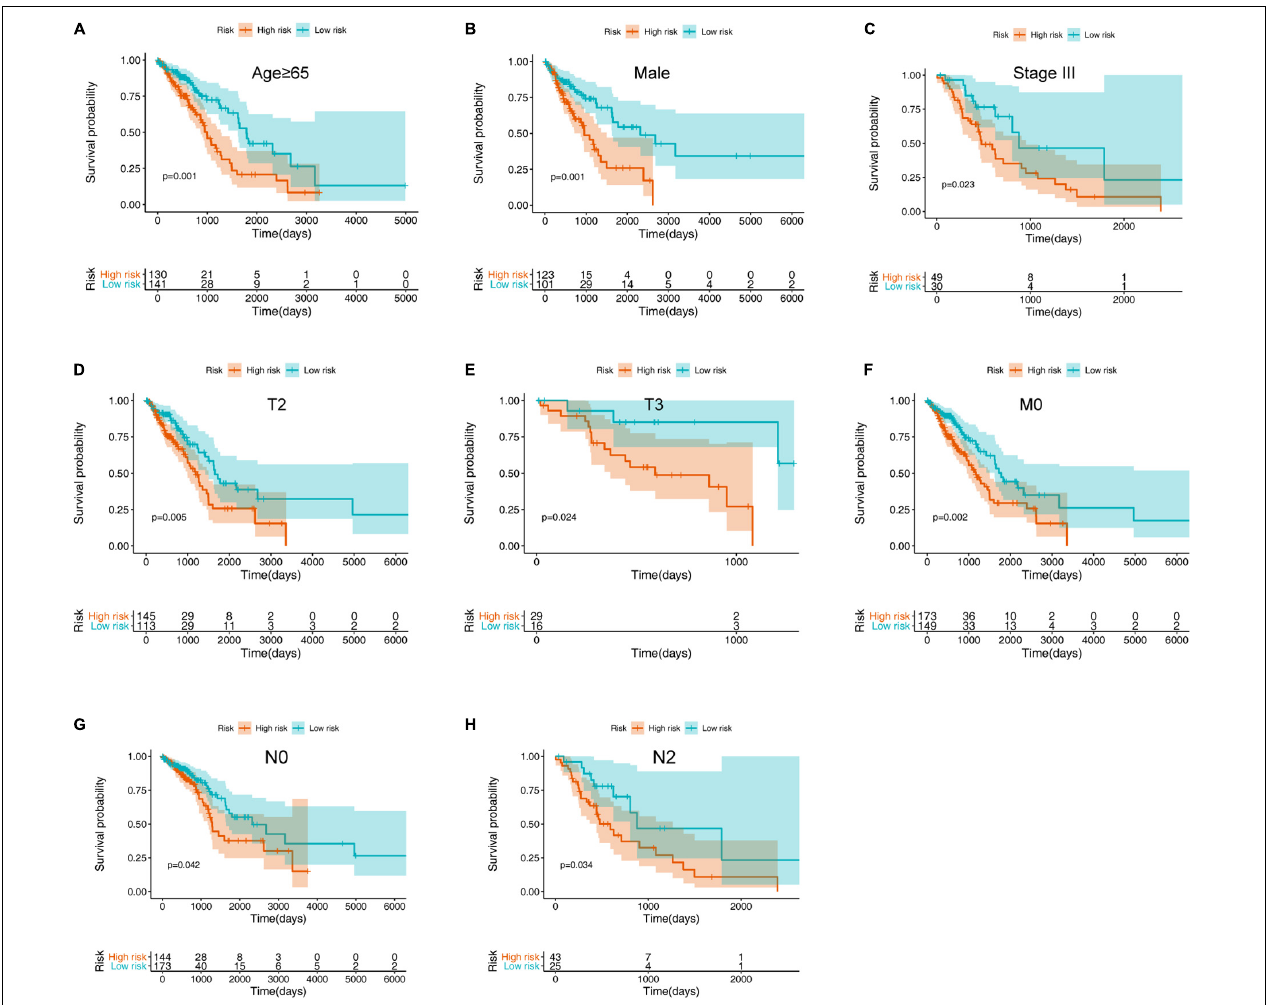
( Figure 4C ). Kaplan–Meier survival curves of low- and high-risk groups in the training set are shown in Figure 4D ( P <